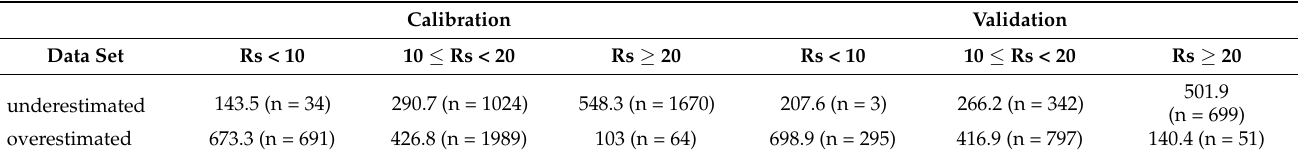
Table 15. RMSE values (J · cm − 2 · day − 1 ) and number of data points belonging to under- and overestimation sets in three defined intervals of measured solar radiation (MJ · m − 2 · day − 1 ) for calibration and validation phases using proposed model. Calibration Validation